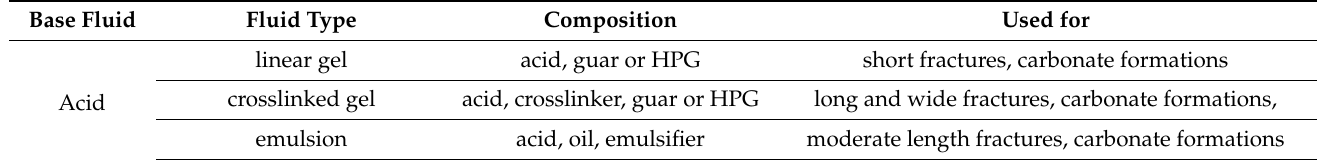
Table 6. Acid-based fracturing fluids.